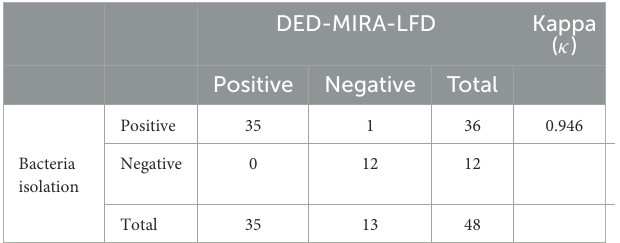
TABLE 2 Comparison of bacterial isolation and DED–multienzyme isothermal rapid amplification (MIRA)–lateral flow dipstick (LFD) results for clinical